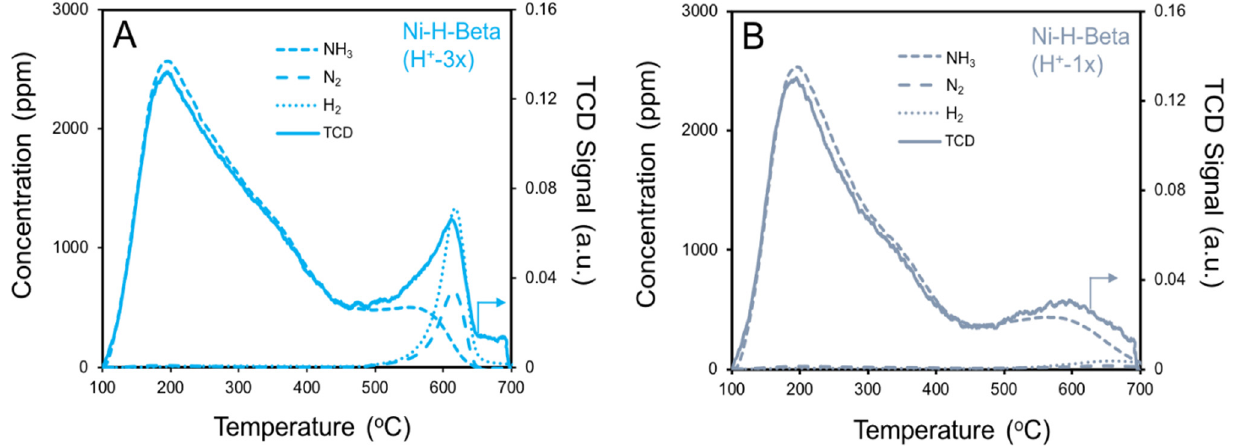
Figure 9. NH 3 TPD with online QMS after in situ pretreatment at 500 °C. ( A ) Ni-H-Beta (H + -3x) and ( B ) Ni-H-Beta (H + -1x).